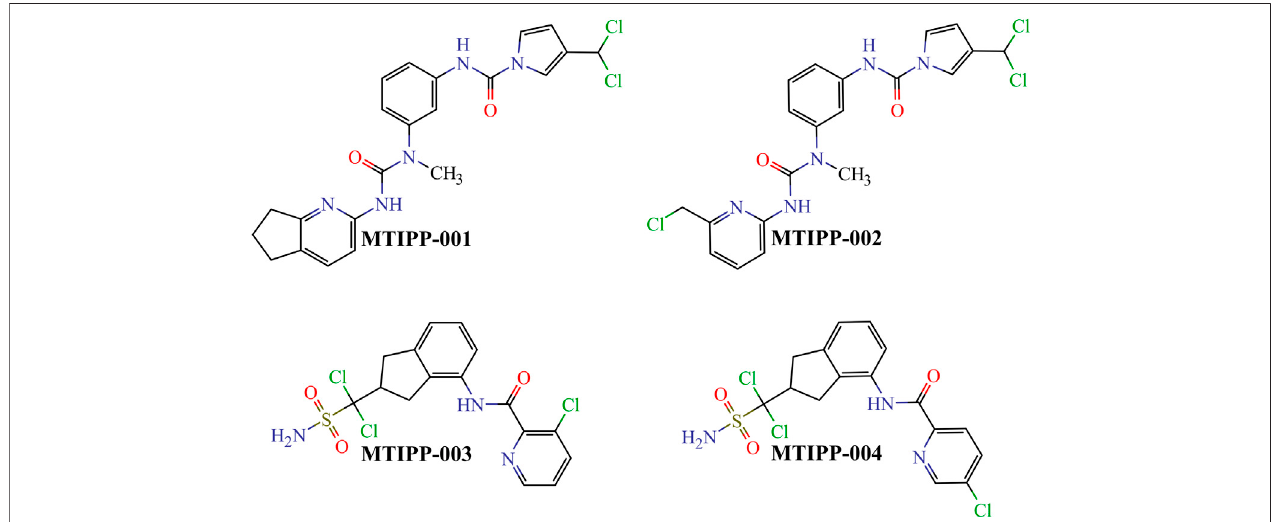
FIGURE 6 | Chemical structures of the molecules designed and predicted by using the mt-QSAR-MLP